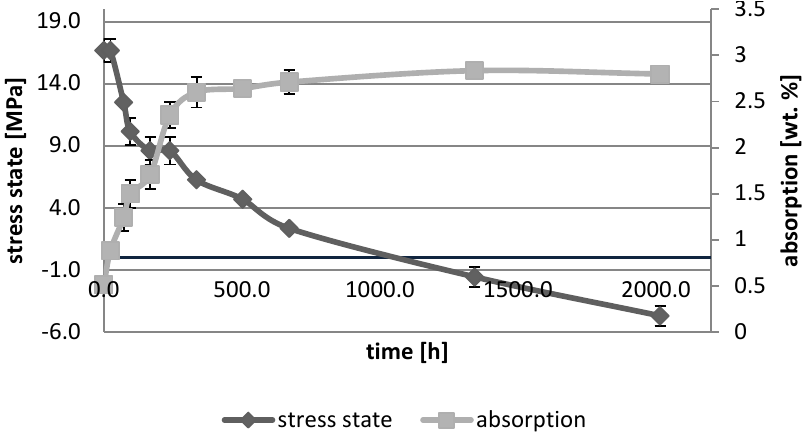
Figure 2. The relationship of absorption and stress state during water ageing (2016 h) of Beautifil Flow Plus F00.